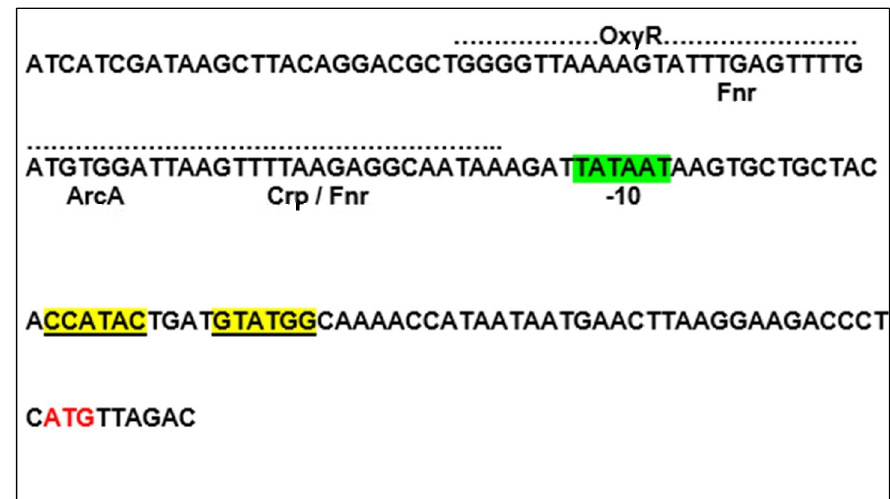
Figure 1. Transcriptional control region of vgb . Transcription factor binding sites are labeled as described in the preceding paragraph. In addition, there is a region of dyad symmetry (highlighted in yellow) downstream of the -10 region (Pribnow box; highlighted in green) that is probably the binding site for an additional as yet unidentified transcription factor. The ATG translational start codon is highlighted in red.